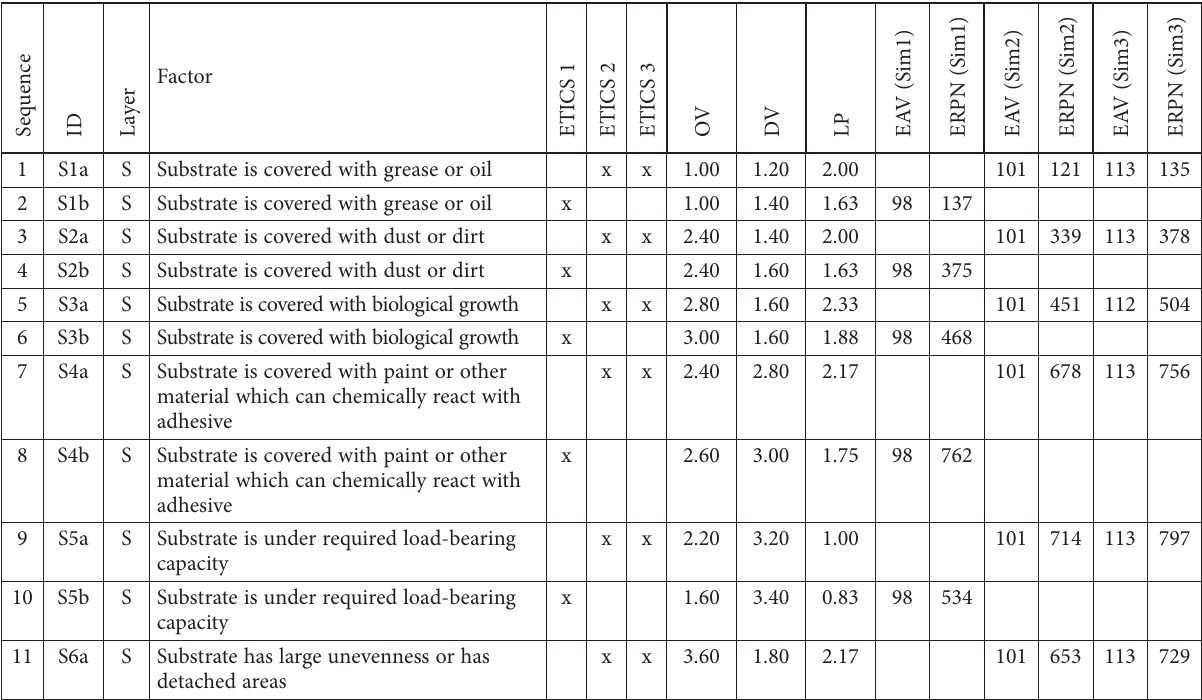
Table A1. Data for equation (1